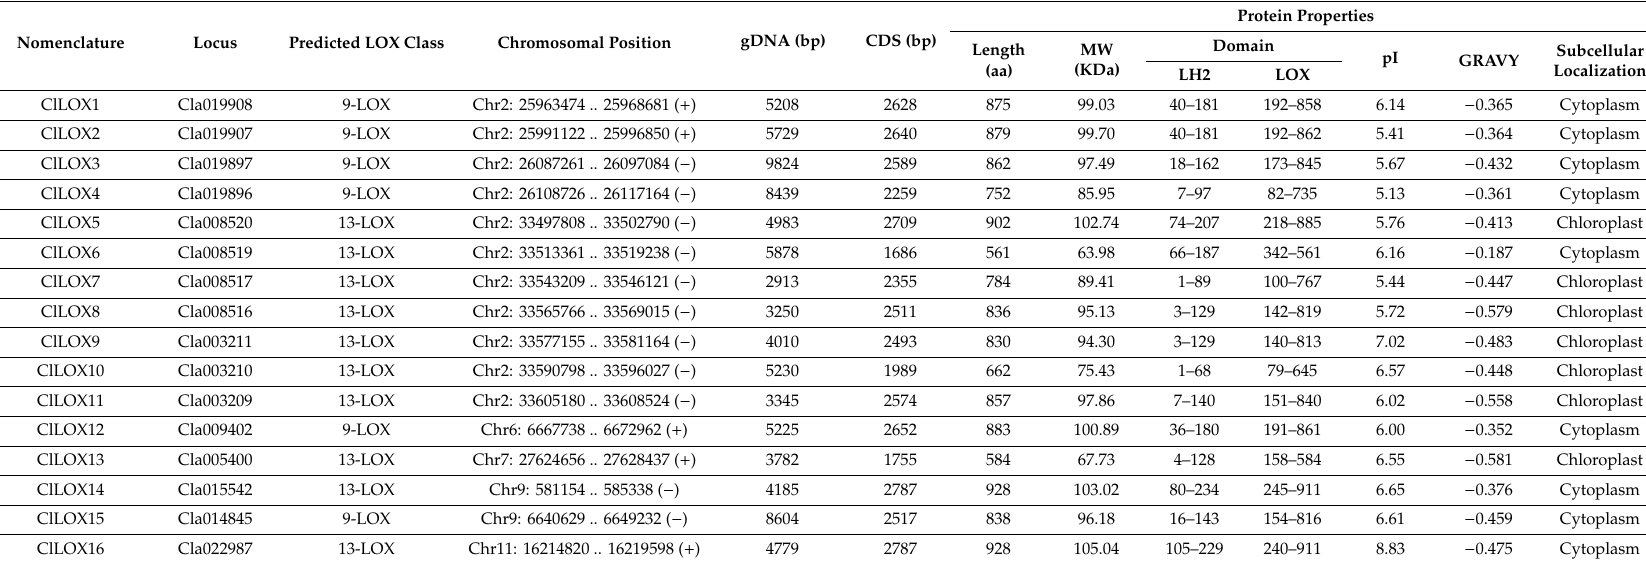
Table 1. Identification and characterization of LOX family genes in